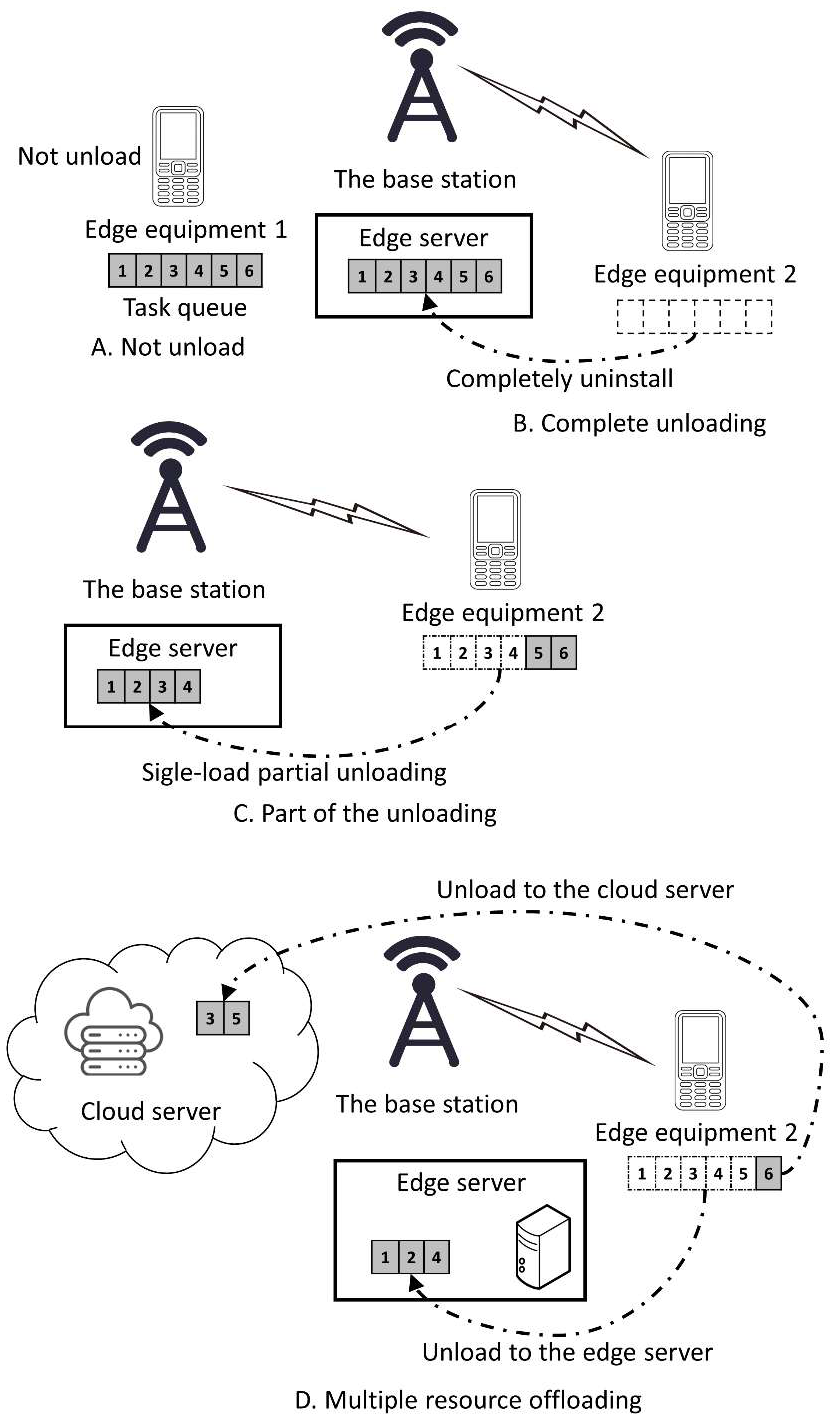
Figure 3. Four unloading